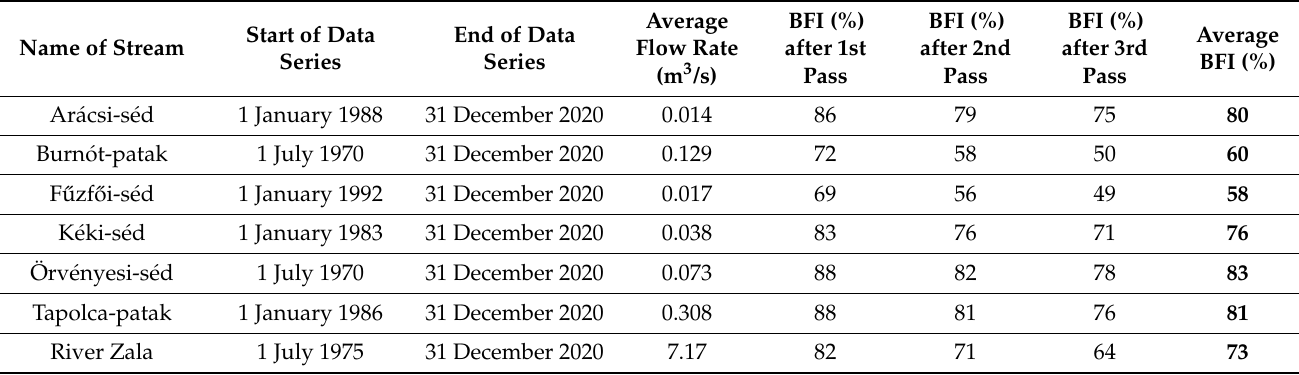
Table 1. Length of data series, average flow rate and baseflow index calculation results for the seven investigated